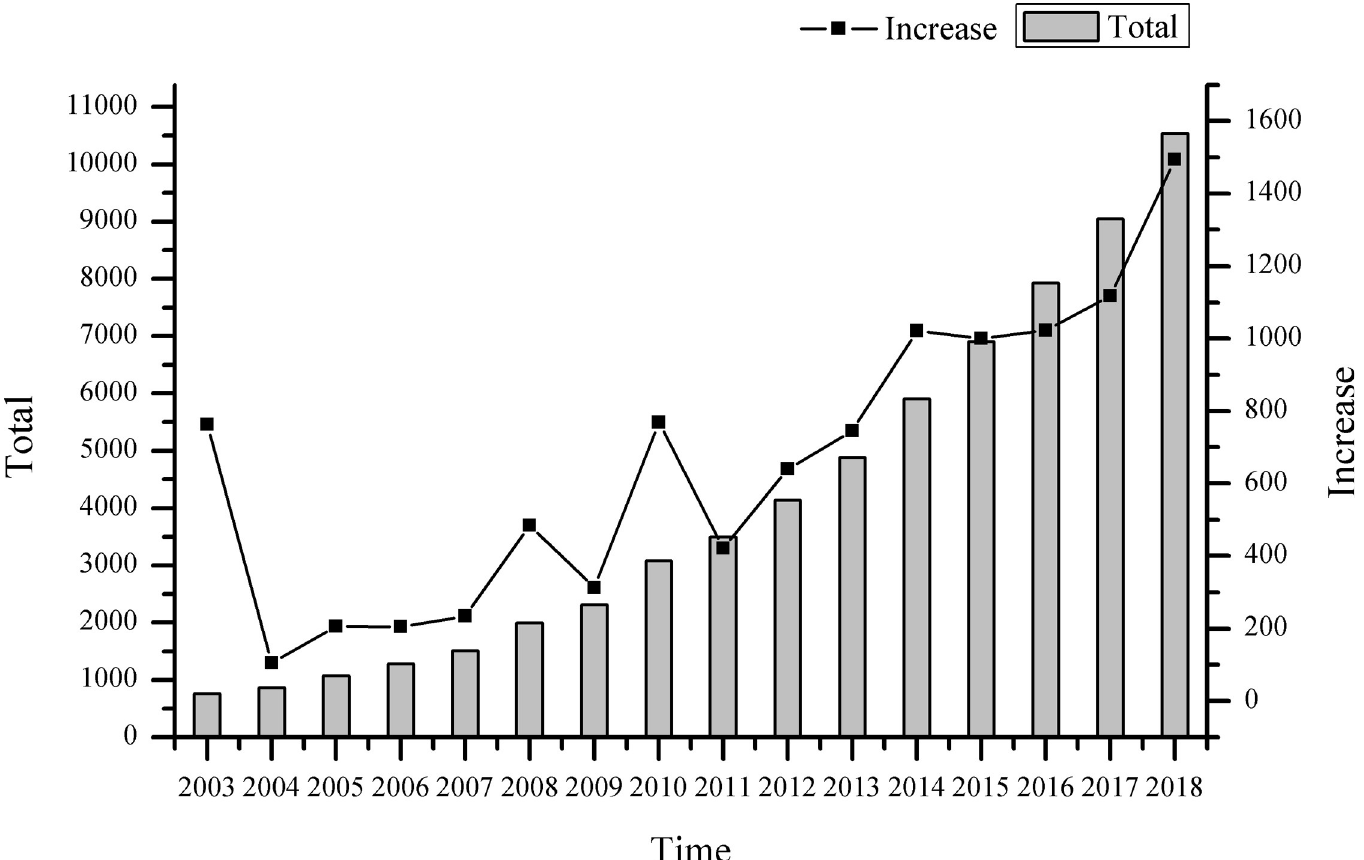
Fig 2. The evolution of hotel quantity in Beijing from 2003–2018. The histogram represents the total number of hotels in Beijing that year, and the line graph represents the number of new hotels in Beijing that year. The data comes from publicly available data on the Internet, the figure is drawn by Qrigin.